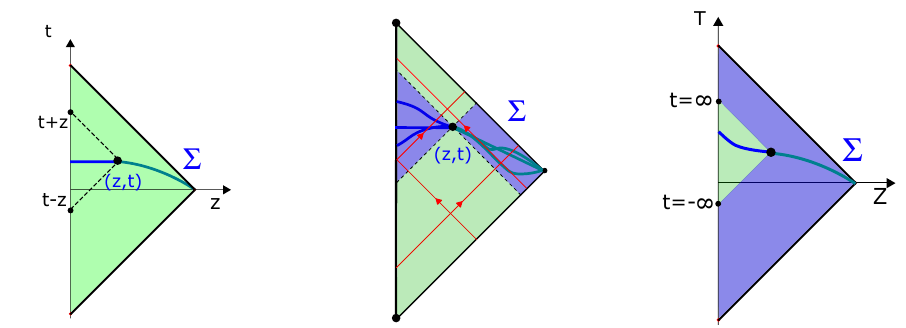
Figure 4 . Left: matter entanglement entropy obtained by dividing a Cauchy slice (cid:6) in two pieces. The bulk point is at ( z; t ). Middle: foliation independence of entanglement entropy on Cauchy slice. One can freely move the Cauchy surface within the blue regions, keeping it spacelike everywhere. Right: z ! + 1 limit, where the entanglement entropy is between the interior (blue) and exterior (green) of the black hole. The full patch is the Poincar(cid:19)e frame. The result agrees with the thermal entropy of the CFT gas surrounding the black